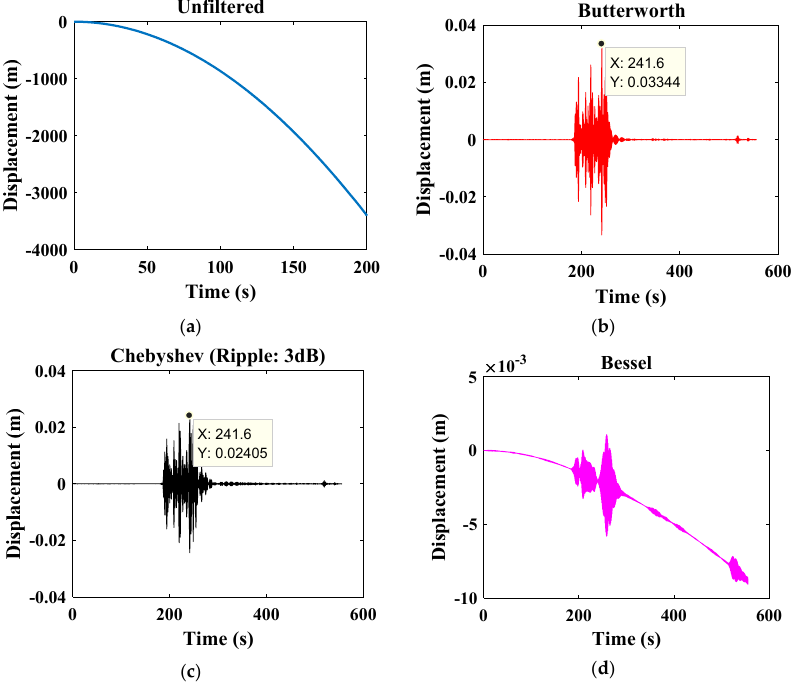
Figure 2. Filtering of the displacement signal ( a ) without filter, ( b ) Butterworth filter, ( c ) Chebyshev filter, and ( d ) Bessel filter.